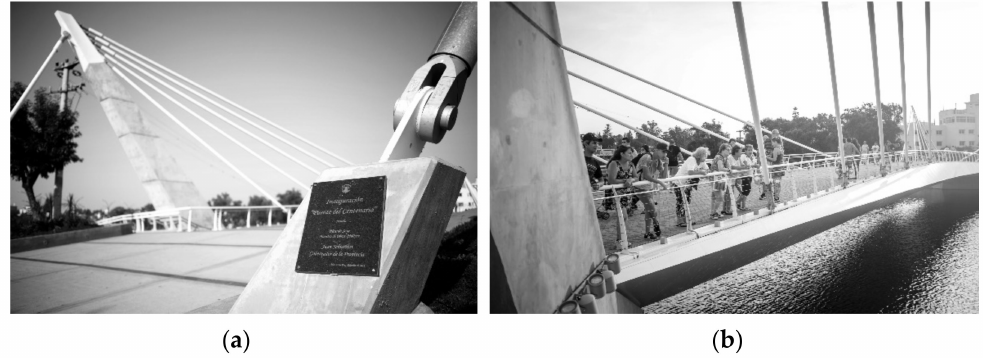
Figure 13. ( a ) Exposed stay attachments as ‘honest’ engineering themes. ( b ) Various activities were observed in the wider areas of the deck, without interfering with the central pedestrian flow.